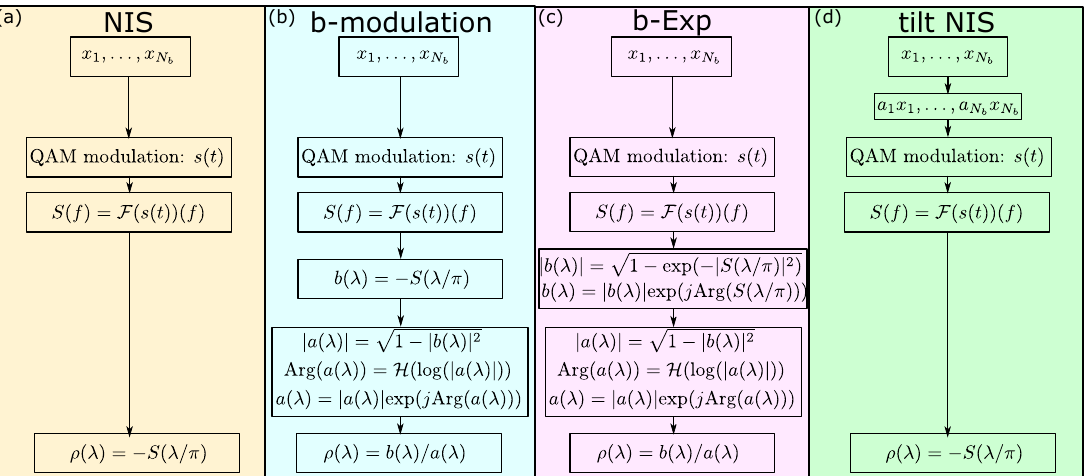
Figure 3. Details of modulations ( a ) NIS modulation; ( b ) b-modulation; ( c ) bExp-modulation; ( d ) NIS + tilt modulation.